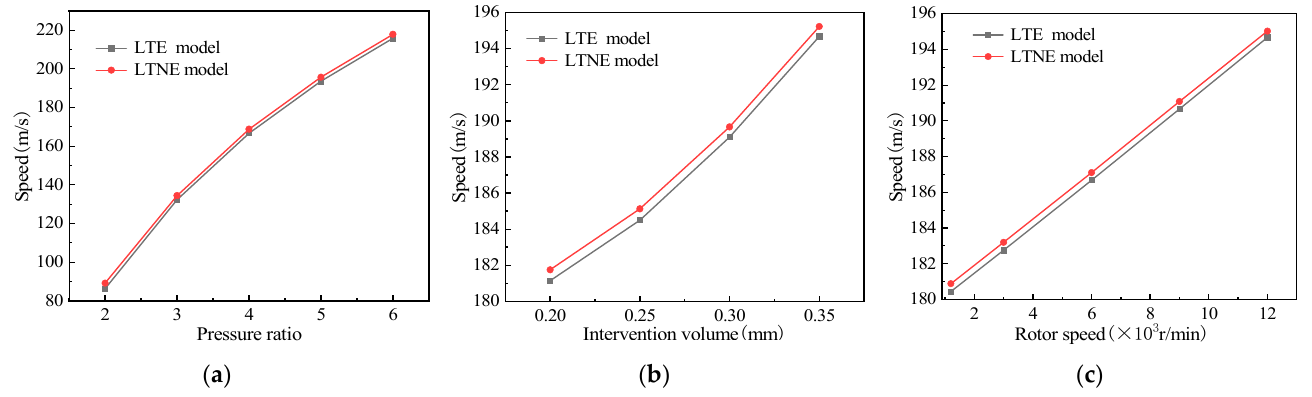
Figure 11. Variation of the fluid flow rate with with pressure ratio ( a ), interference amount ( b ), and rotational speed ( c ).